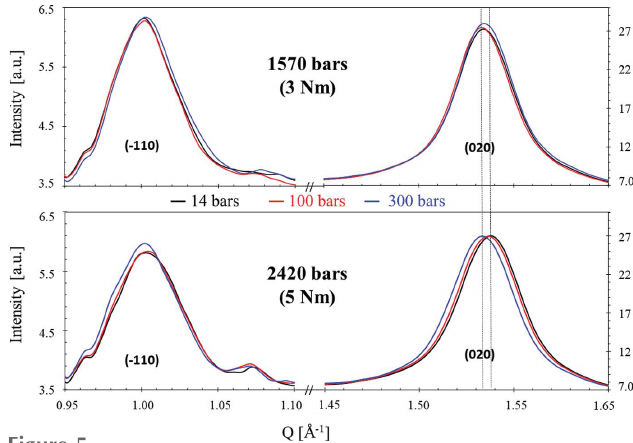
Figure 5 Influence of the hydrostatic pressure at fixed compressive pressure (torque values of 3 N m and 5 N m). The vertical lines are a guide to the eye to directly observe the effect of pressure on membrane swelling.